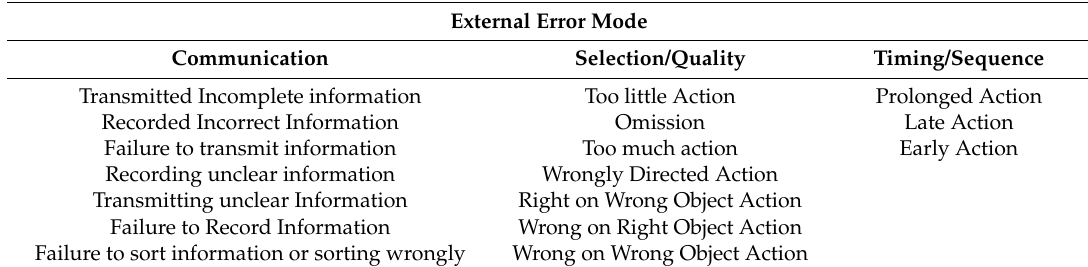
Table 5. External Error Mode Taxonomy of observable